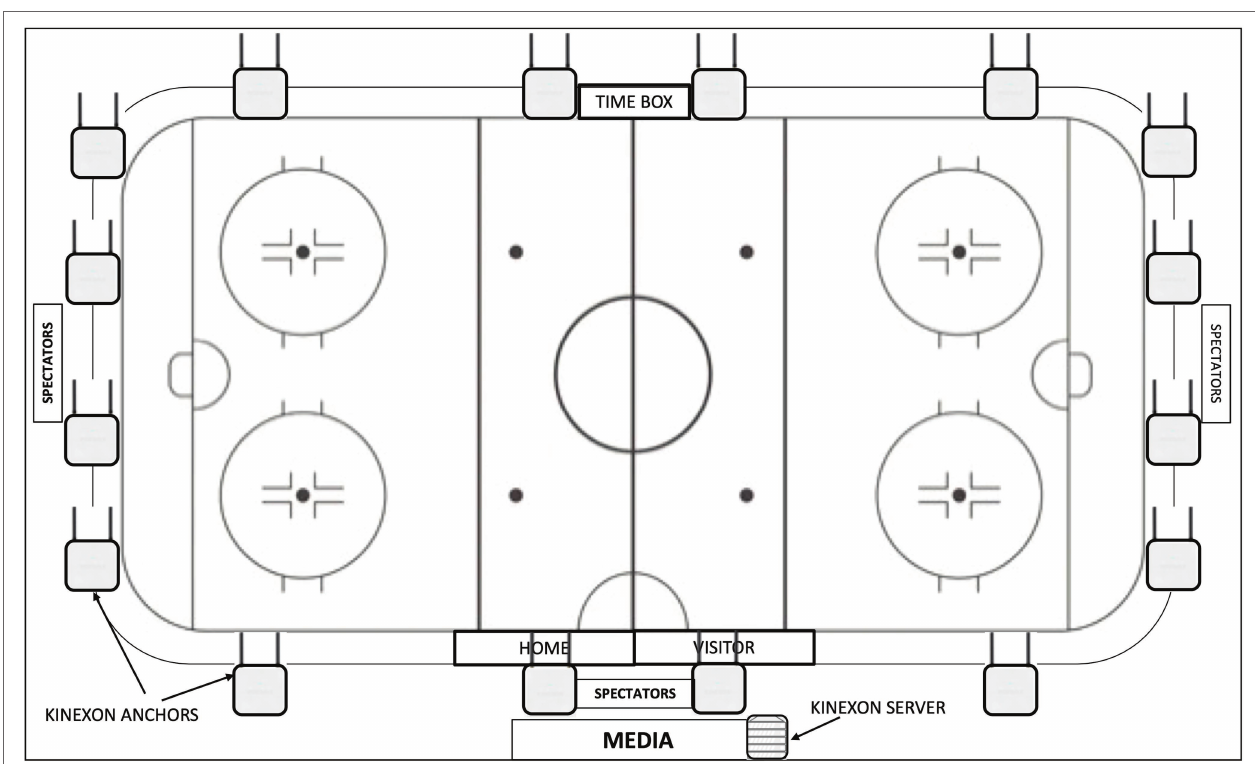
FIGURE 1 | Schematic diagram outlining the location of one server and 16 anchors that allow for on-ice player tracking during games and practices using an ultra- wideband local positioning system (Kinexon, Munich, Germany).